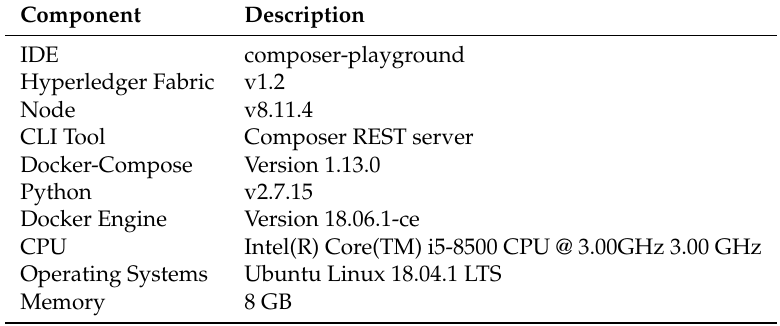
Table 1. Development environment for the proposed drug supply chain management in a medical blockchain platform.